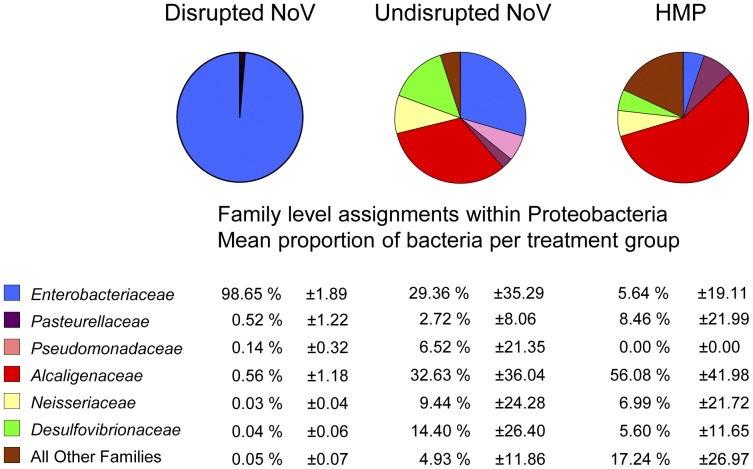
Patients with high Proteobacteria are dominated by high levels of Enterobacteriaceae.The average family level diversity within all Proteobacteria reads showed that the vast majority of Proteobacteria in disrupted patients was Enterobacteriaceae. Undisrupted and HMP patients had lower overall reads, and showed a higher diversity of reads within Proteobacteria, but lacked a single dominant bacterial family.